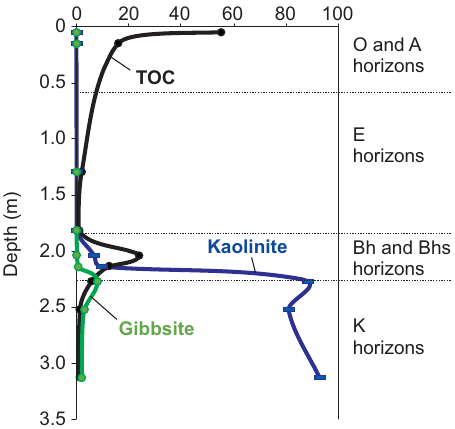
Fig. 3. Solid soil phase: kaolinite, gibbsite and total organic car- bon (TOC) in the podzol from the upper part of the catena (Pit 1). Horizontal axis is in % for kaolinite and gibbsite and in ‰ for TOC.